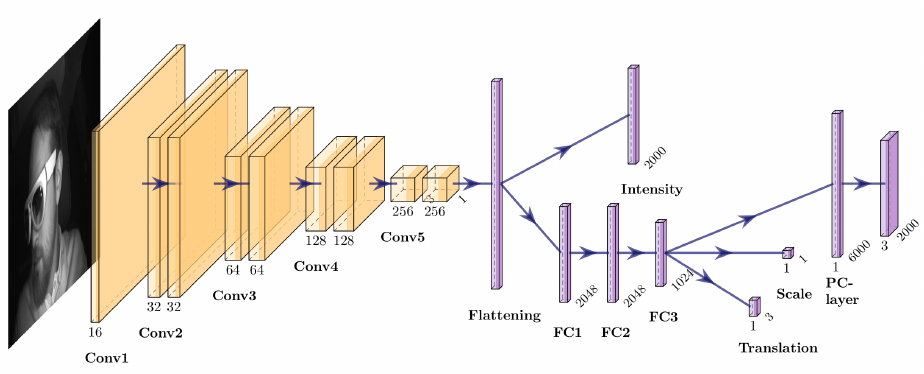
Figure 4. An overview of the CNN architecture. We use convolutional layers to extract features from the input image. The number of filters is doubled per convolutional block. The kernel size changes between one and three, starting with three in the first layer of the first convolutional block. While color information is directly regressed from the flattened feature vector, a decoder processes the feature vector before scale, translation and point cloud are